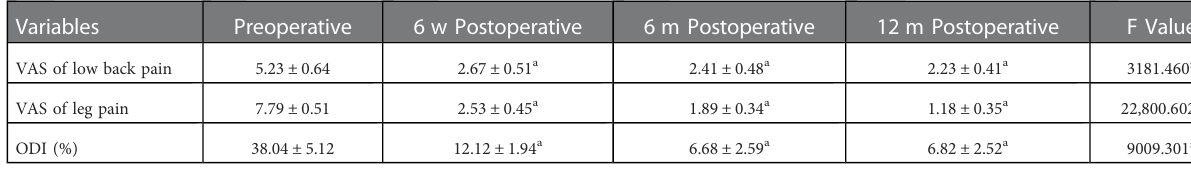
TABLE 1 Changes in preoperative and postoperative ODI, VAS scores of low back pain and leg pain.